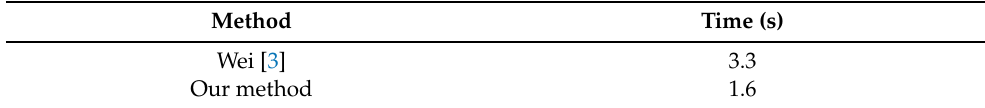
Table 2. Average Time on FDWW dataset